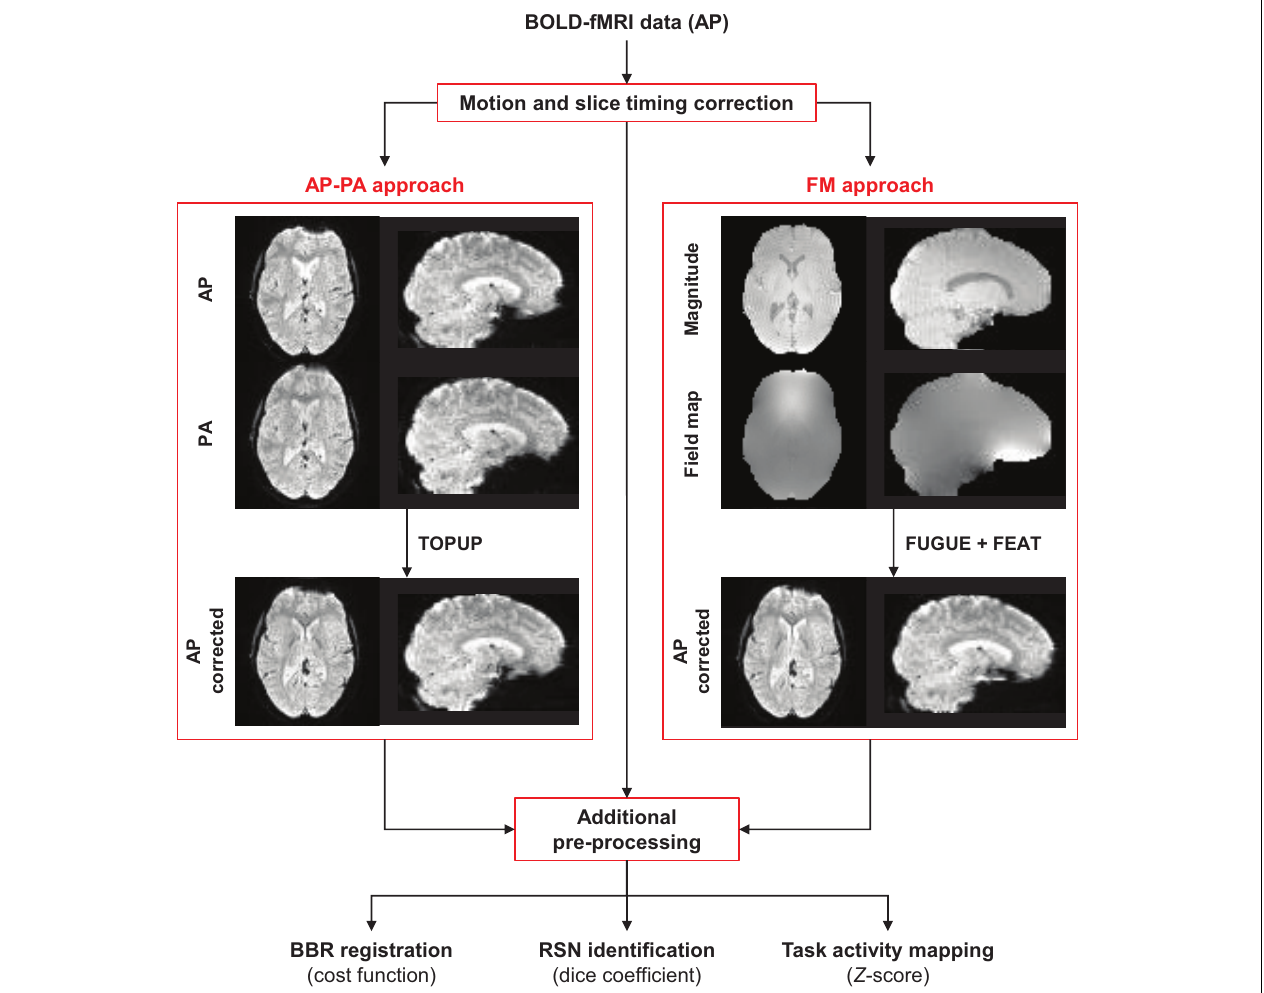
FIGURE 1 | Schematic diagram of the processing pipeline. The fMRI data of each functional run (collected with the AP phase encoding direction) is first submitted to motion and slice timing correction. Then, geometric distortions are corrected using TOPUP (requires one AP and one PA functional image) or GRE (requires a magnitude and a displacement field converted to radian/s) approaches. Subsequently, additional pre-processing steps are performed on the corrected and uncorrected data, followed by the three different data analyses: (1) registration into structural data, (2) identification of resting-state networks, and (3) mapping of task-related brain regions of